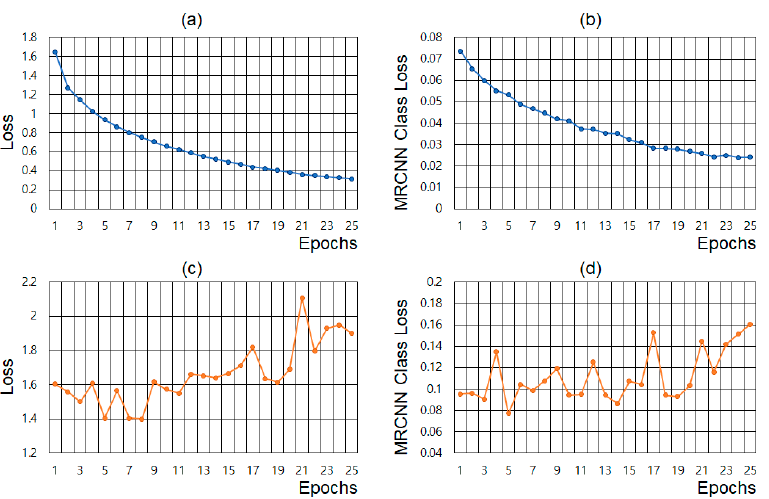
Figure 3. Learning curves for Mask R-CNN: ( a ) training loss, ( b ) training mrcnn class loss, ( c ) validation loss, and ( d ) validation mrcnn class loss.